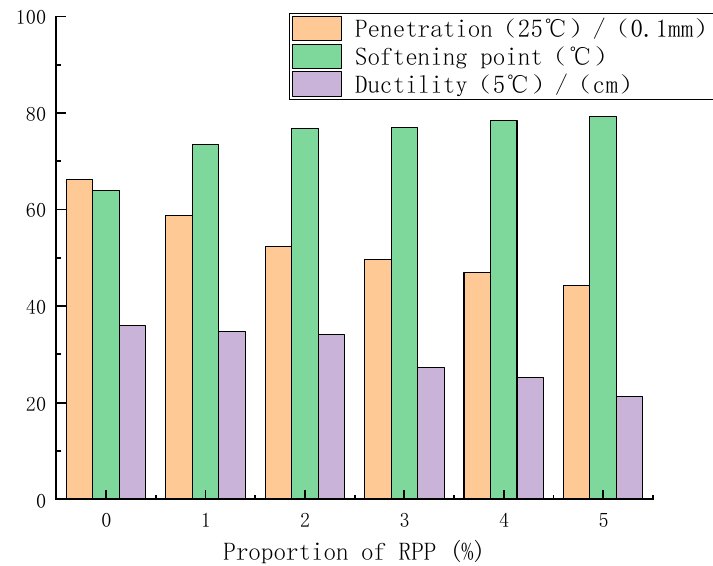
Figure 9. Influence of RPP content on three modified asphalt indexes.